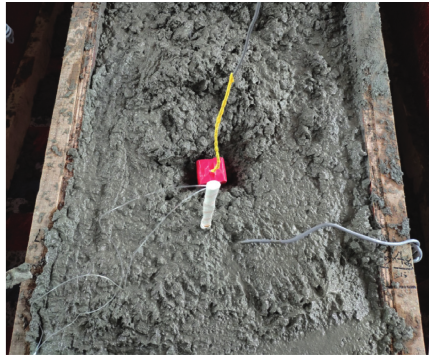
Figure 9: Installation of acceleration